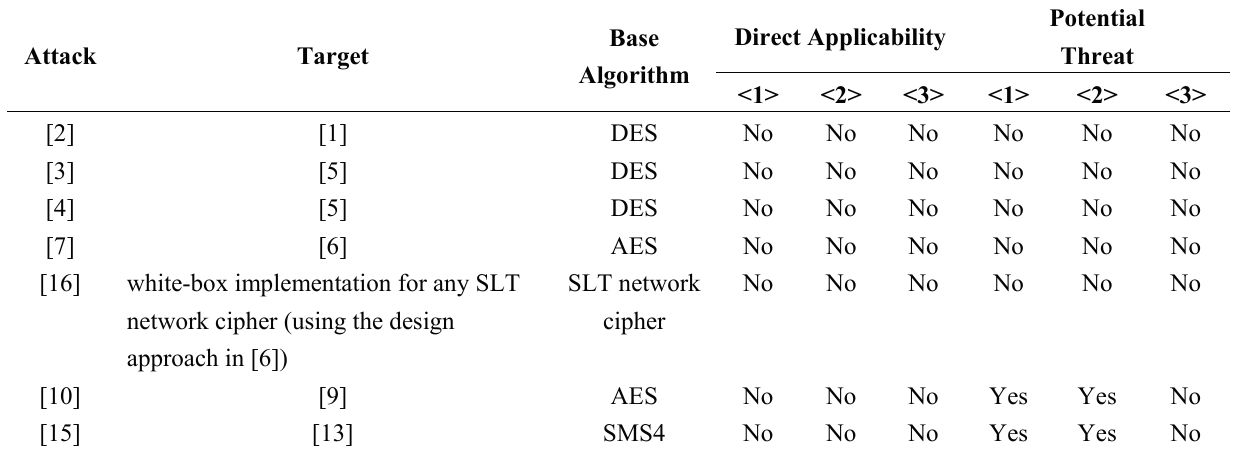
Table 3. Attacks against white-box